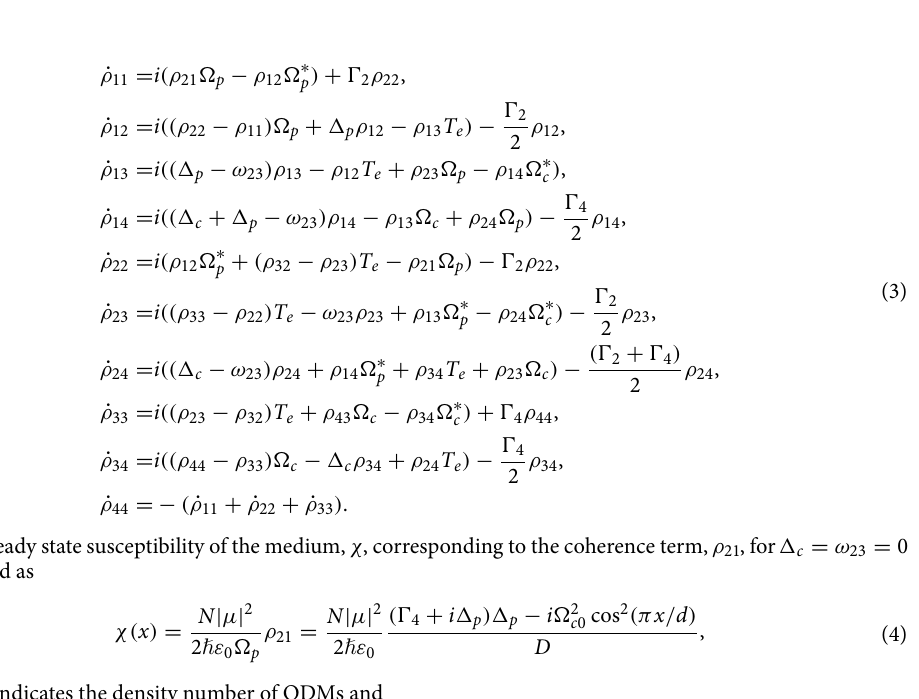
Figure 2. A possible arrangement of the QDM system including the input probe field with the plane wavefront, standing coupling field, the output probe field profile and its image